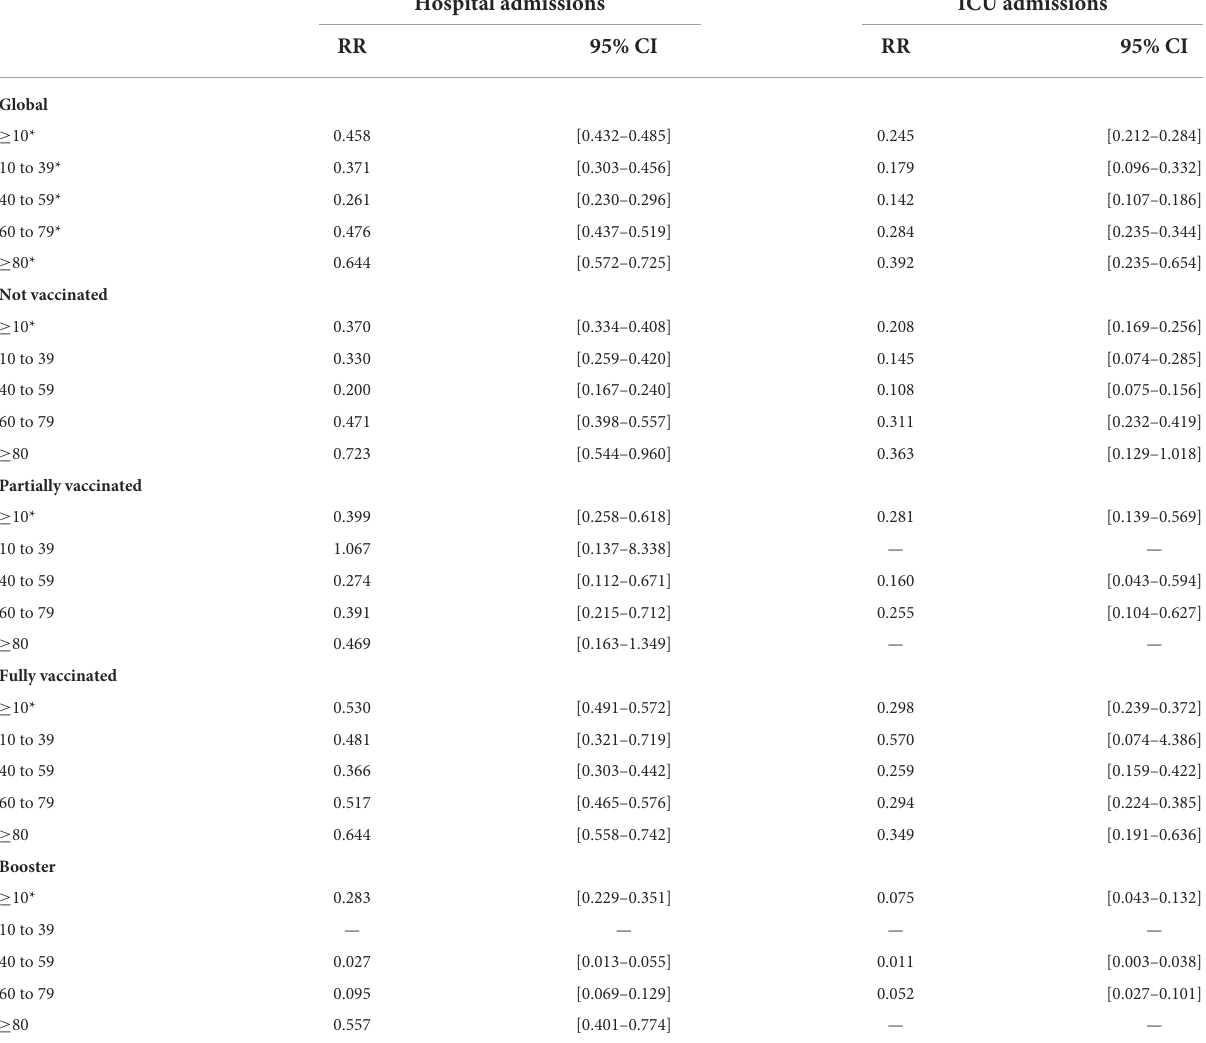
Table 4. From this fit, the average hospitalization RR at the population level, α , was estimated between 0.19 and 0.50,